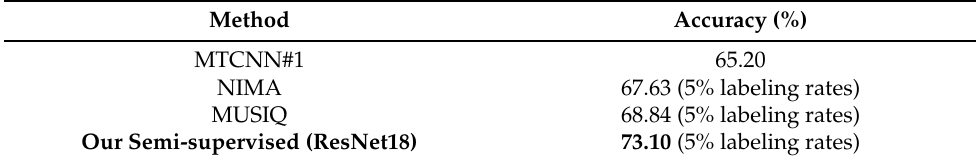
Table 6. Comparison with state-of-the-art methods on the Photo.net dataset.